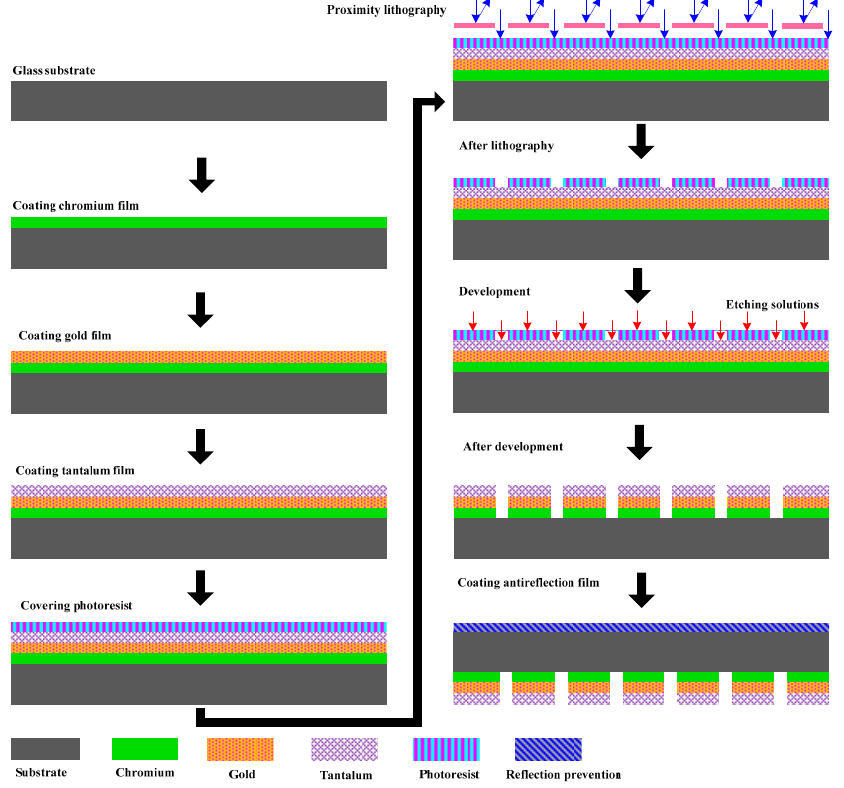
Figure 4. SM process for fabricating the point-source mask.